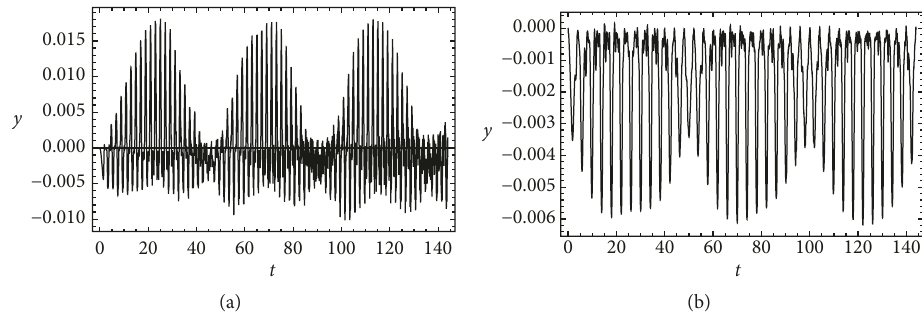
Figure 5: Asymptotic behavior of the back and forth motion, when 𝑃 = 0.01 , 𝜇 = 0.1 , 𝜉 0 = 0.01 , and 𝑡 𝑡 = 4 ; 𝑁 𝑒 = 50 : (a) 𝑎 = 0.98 ; (b) 𝑎 = 0.48